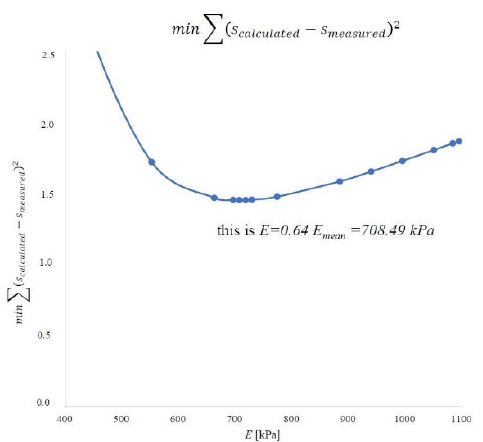
Figure 22. According to the first method, the representative value of the constrained modulus of elasticity of the peat material on the island of Ostrów Brdowski in Szczecin.